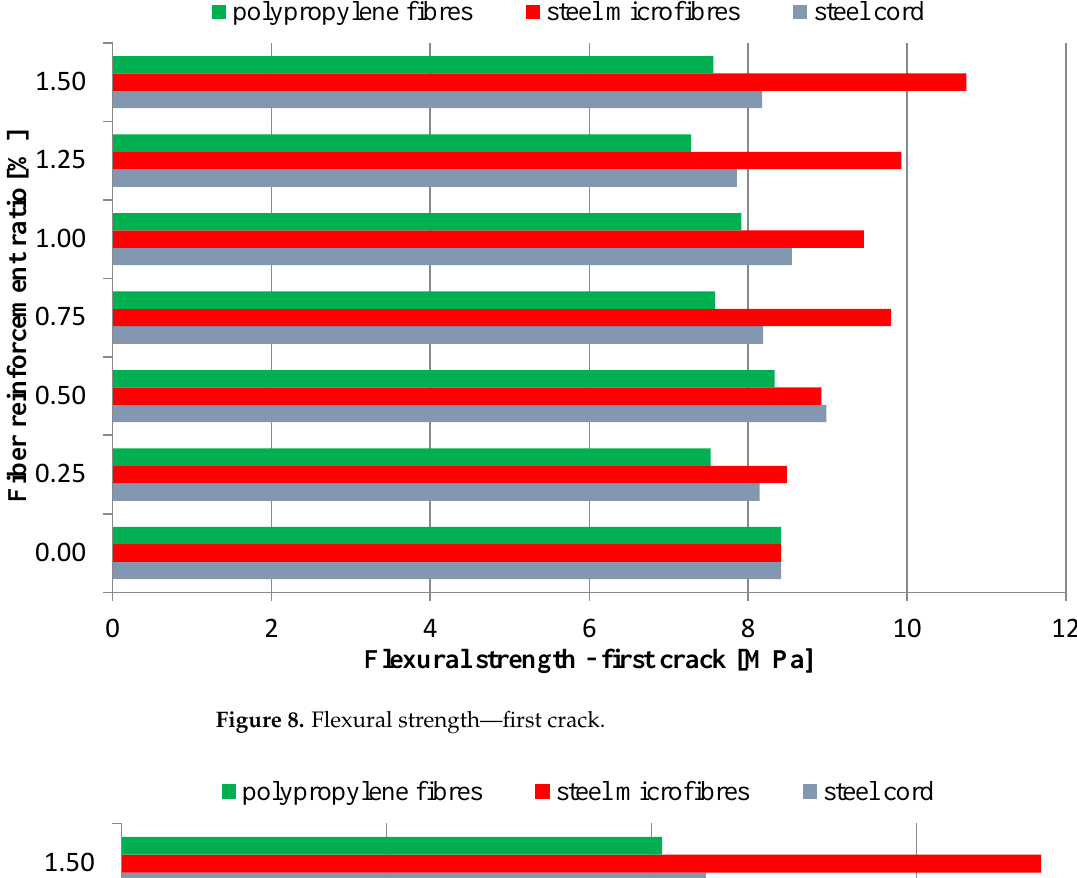
Figure 7. ( a ) Flexural strength and ( b ) compressive strength tests.